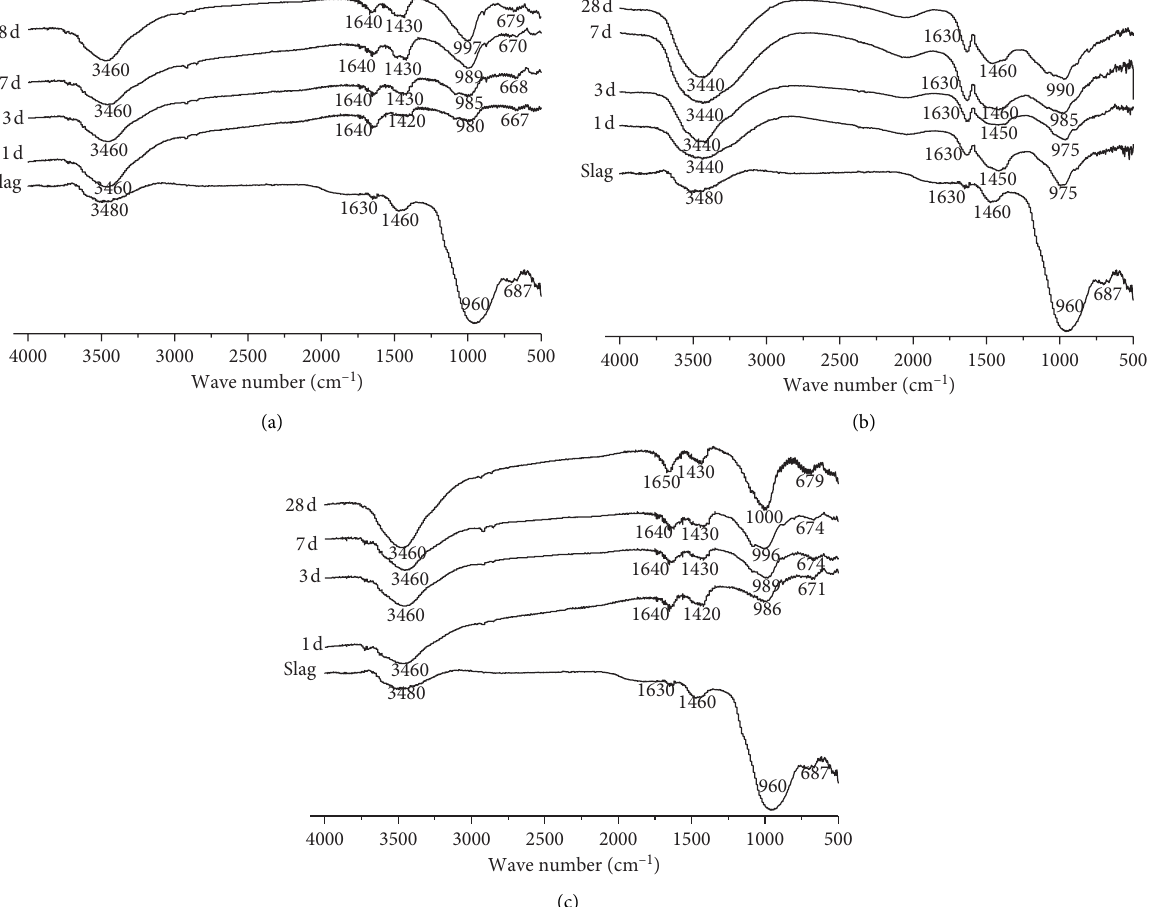
Figure 14: FT-IR spectrum of the alkali-activated nickel slags when the Na (c)